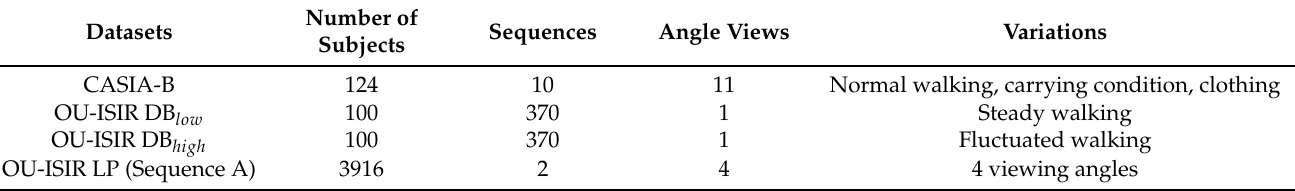
Table 2. Summary of datasets.